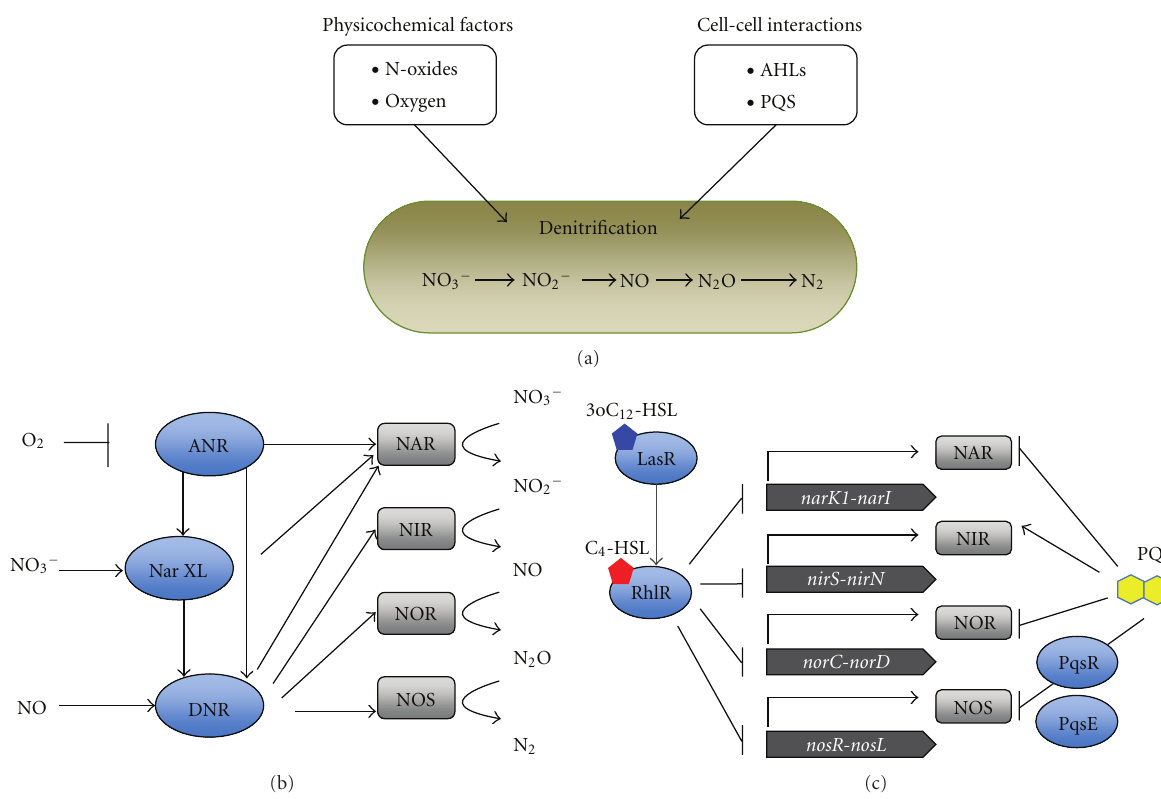
Figure 1: (a) Denitrification regulation in P. aeruginosa . Denitrification is regulated by physiochemical conditions, such as oxygen concentration and the availability of nitric oxides as well as cell-cell communication molecules. (b) Denitrification regulation by physiochemical factors in P. aeruginosa. ANR is activated under low-oxygen tension conditions, which increases the transcription of the NarXL two-component system and DNR. NarXL responds to nitrate and activates the expression of DNR together with ANR. DNR is activated in the presence of NO and induces the transcription of the four reductases. The narK1K2GHJI operon, which encodes nitrate/nitrite transporters and the structural gene for NAR, is also induced by ANR and NarL. (c) Denitrification regulation by cell-cell communication. C 4 -HSL and 3-o-C 12 -HSL repress the transcription of denitrifying reductases via their cognate receptors RhlR and LasR. Regulation by LasR is dependent on RhlR. PQS represses the activity of the NAR, NOR, and NOS enzymes while activating the NIR enzyme. PqsR and PqsE are involved in the PQS e ff ect on NOR, while the e ff ect on the other three enzymes does not require PqsR or PqsE.